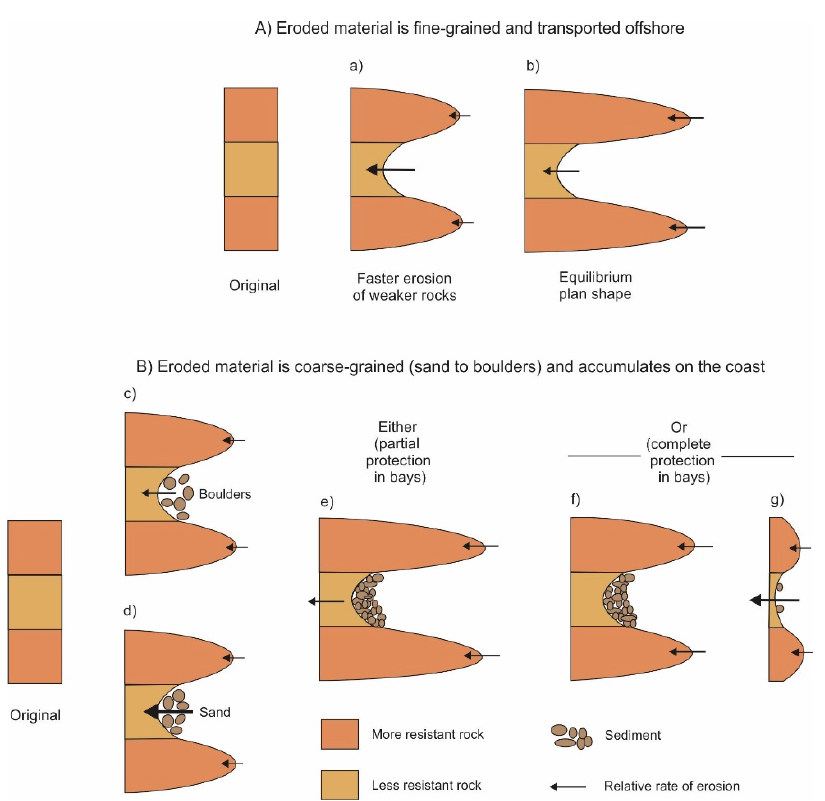
Figure 6. Possible modes of development of coasts with alongshore variations in rock resistance with fine-grained ( A ) and coarse-grained ( B ) sediment. In ( A ), an equilibrium plan shape develops, due to wave refraction, with stronger waves eroding the harder rocks on the headlands at the same rate as weaker waves erode the less resistant rocks in the bay. In ( B ), the amount and mobility of the sediment determine whether it plays an abrasional (d) or protective role (c). Equilibrium planform amplitude may develop if some erosion can continue in the bays (e), but complete protection in the bays would cause headland amplitude to decrease (f) and eventually allow sediment to be swept around them, thereby initiating a new cycle of erosion (g)